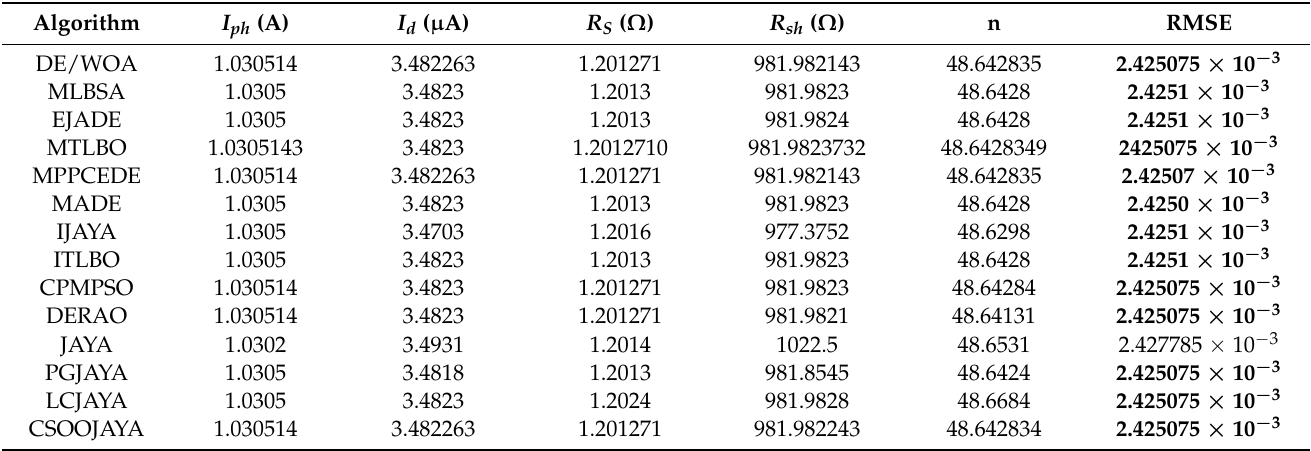
Table 9. Comparison of the extracted optimal parameters of the PV